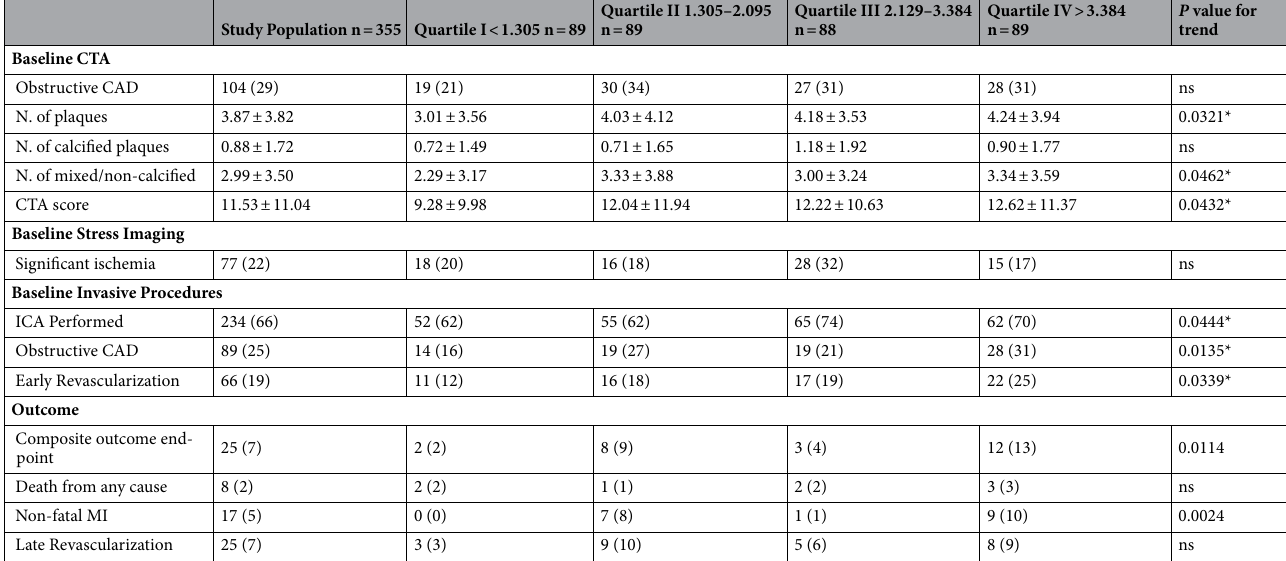
Table 3. Imaging and Outcomes in the study population and in groups defined by TG/HDL-C quartiles. [Continuous variables are presented as mean ± standard deviation, categorical variables as absolute N and (%); * = P value only for comparison of Quartile IV vs. Quartile I].